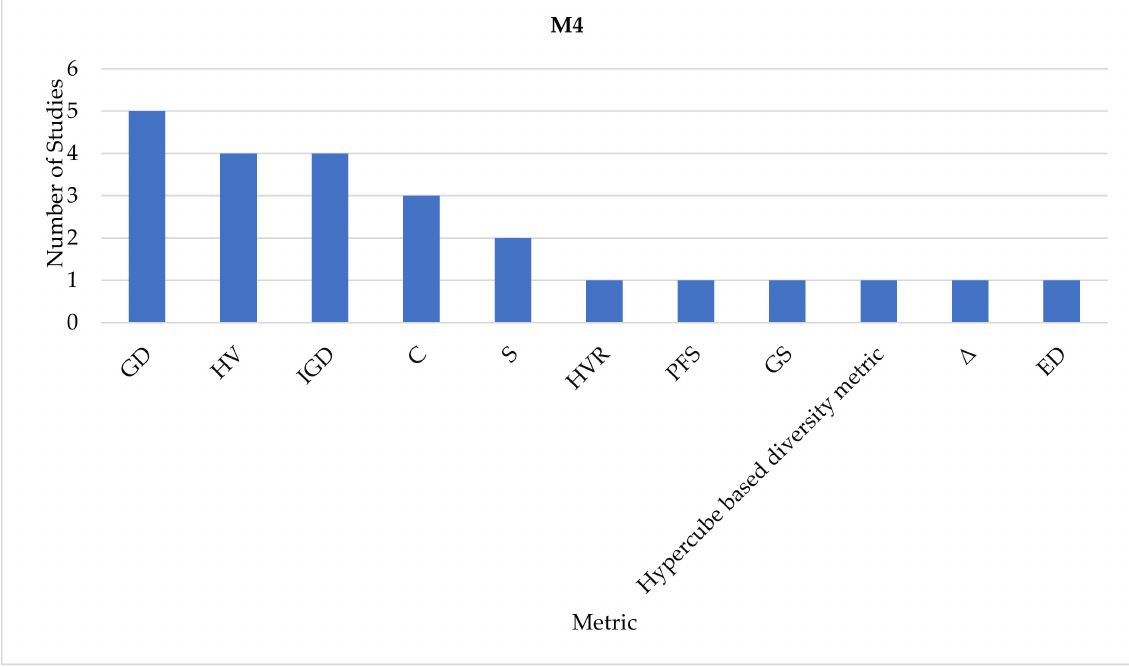
Figure 7. Metrics distribution in M4 group.